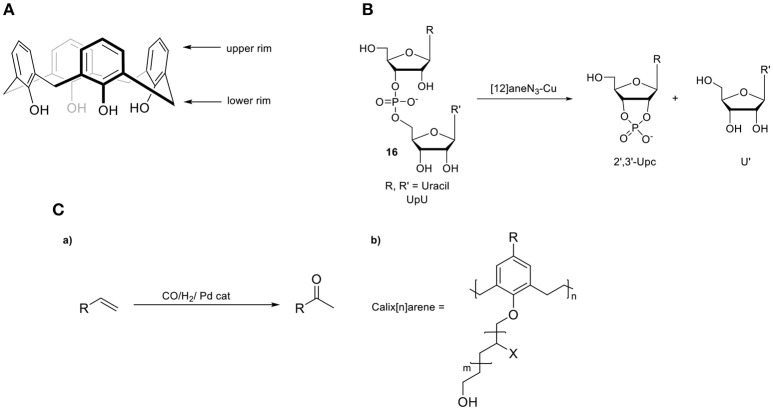
(A) Calixarene backbone. (B) Intramolecular transesterification of UpU (16) by a copper calixarene catalyst. (C,a) Wacker oxidation and (b) the applied calix[n]arene.